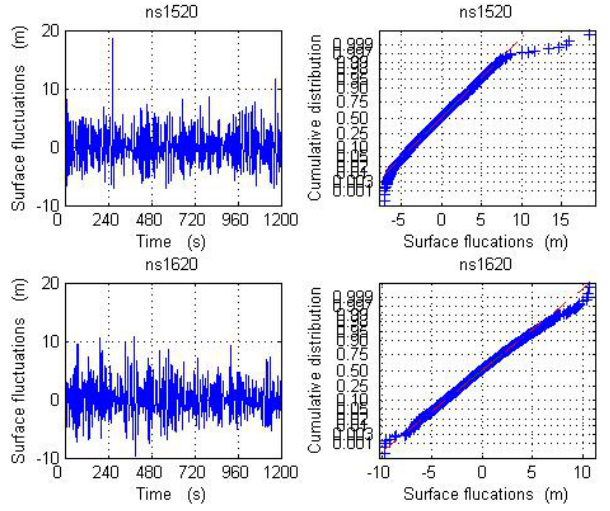
Figure 8. Correlation of the ratios of H max /H s with H max /H 1/3 . The blue line represents the 1:1 perfect fit. The red line is a best eyeball fit, 0.85:1 in this case. The points with a red circle around are the visually picked freaque wave cases.